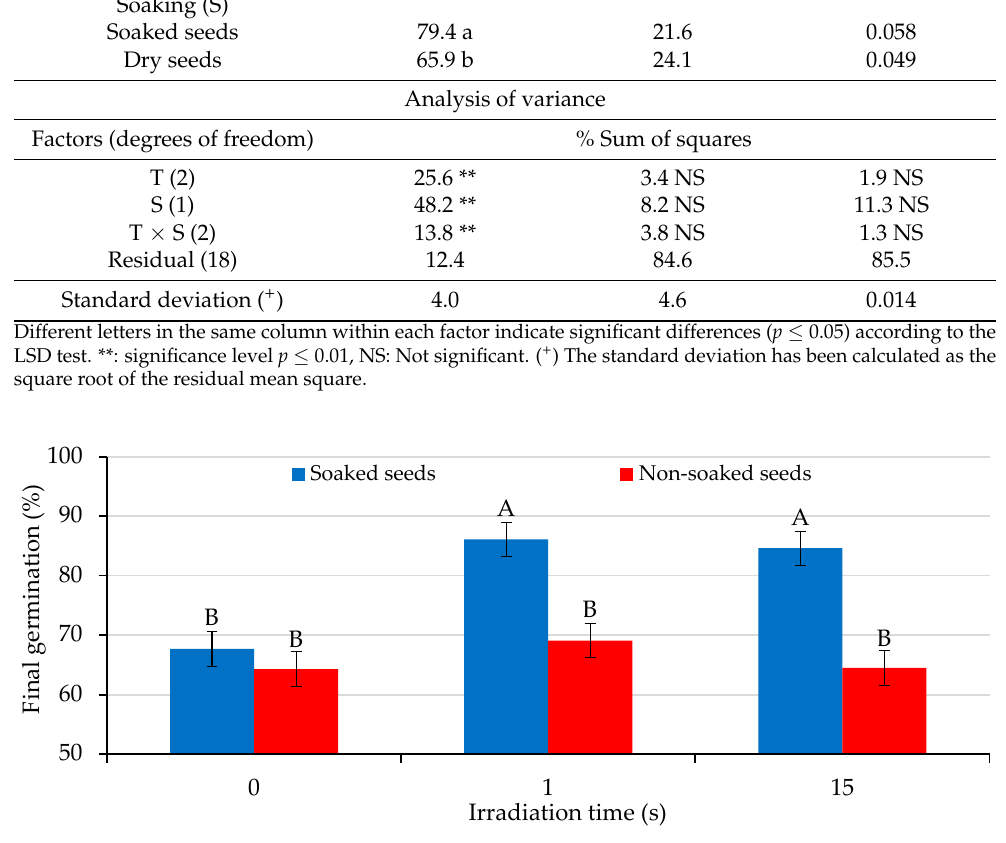
Figure 5. Analysis of the significant interactions of the analysis of variance in Table 5 between irradiation time and seed soaking prior to irradiation on the final germination. Average values of four replicates. Different letters indicate significant differences according to the LSD test. Error bars represent the LSD ( p ≤ 0.05).